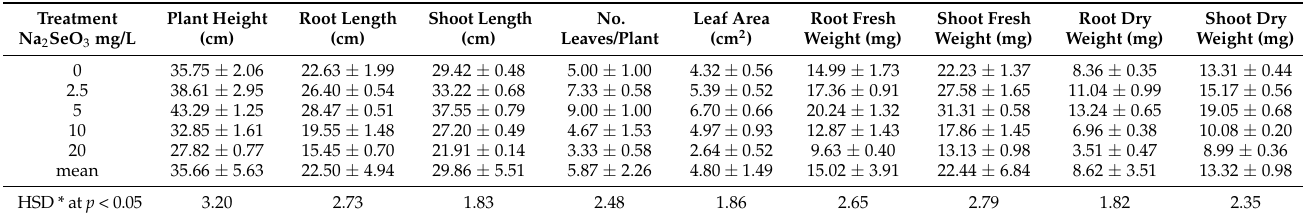
Table 1. Effect of various selenium levels (Na 2 SeO 3 ) on plant growth parameters of plants’ growth after 30 days of selenium treatment. Number of samples 15:5 replications and 3 biological replicates. Treatment Na 2 SeO 3 mg/L